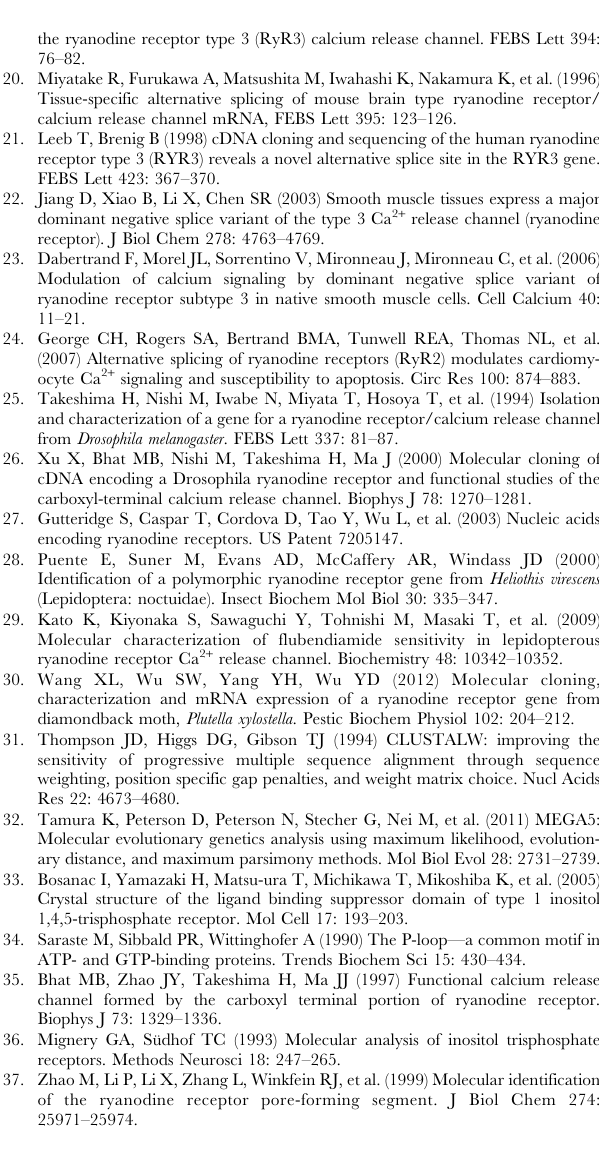
Figure S1 Alignment of amino acid sequence of partial COOH-terminal region in 31 RyR isoforms from 26 species. Identical amino acids are shown in black boxes and similar amino acids are highlighted in gray boxes. Gaps have been introduced to permit alignment. Triangles below the